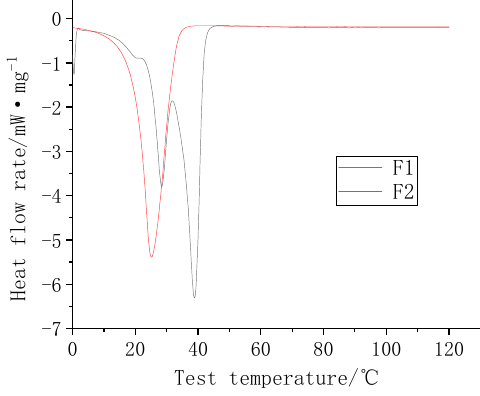
Figure 9. F1 and F2 DSC diagrams.